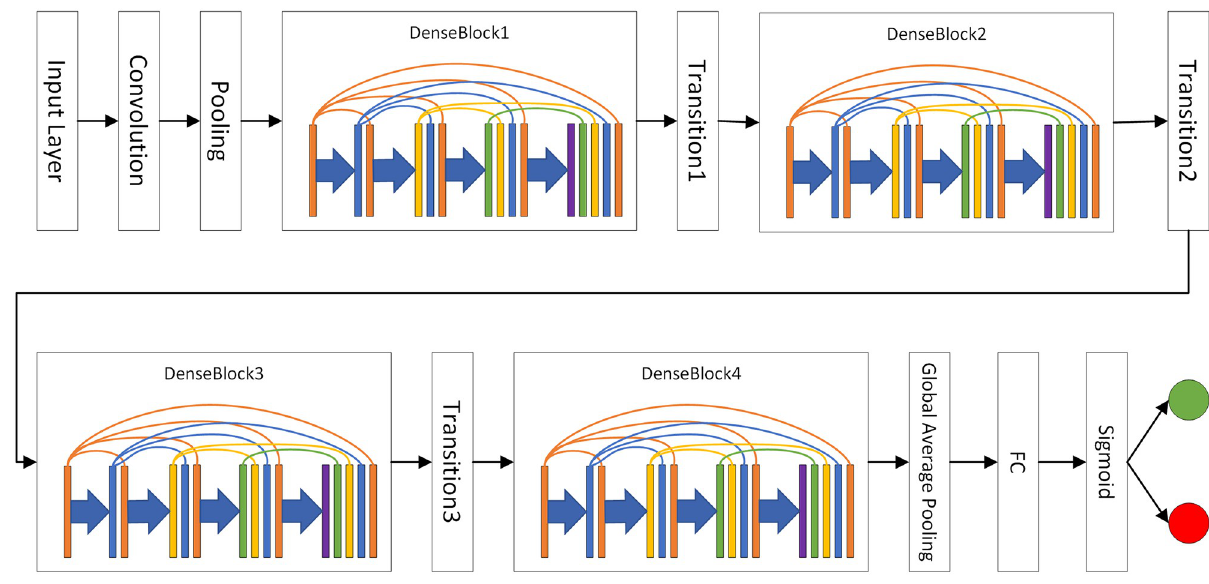
Fig 6. The architecture of the proposed model based on